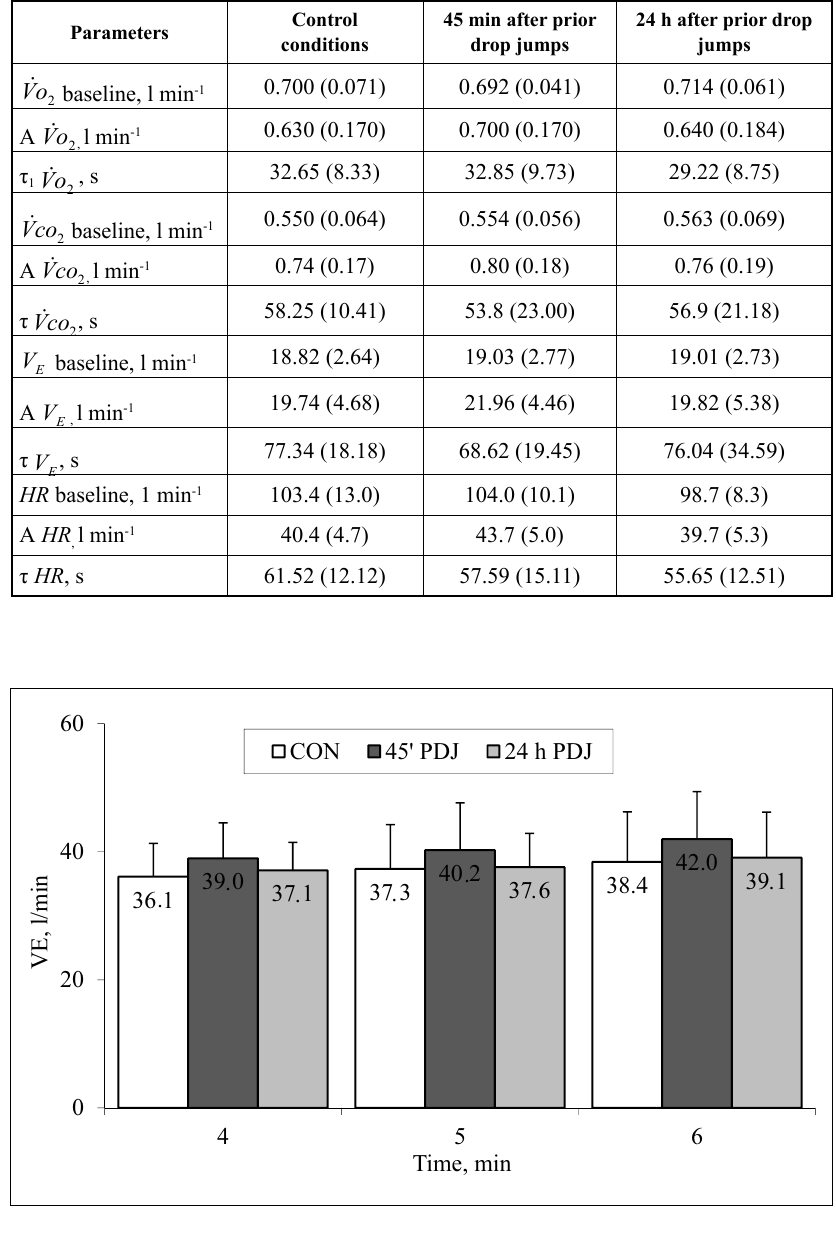
Table 2. Cardiorespiratory parameter responses to moderate intensity cycling exercise under control 45 min and 24 hours after prior drop jumps